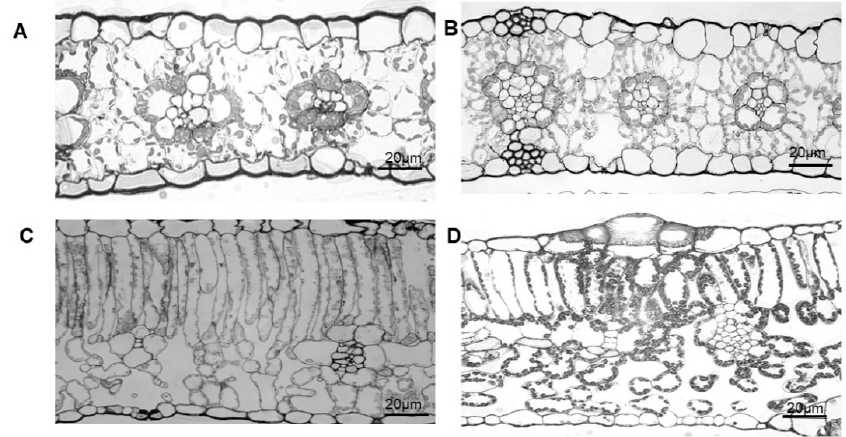
Figure 1. Leaf microstructure of various plant species. ( A ) maize; ( B ) sorghum; ( C ) cotton; ( D ) cucumber.